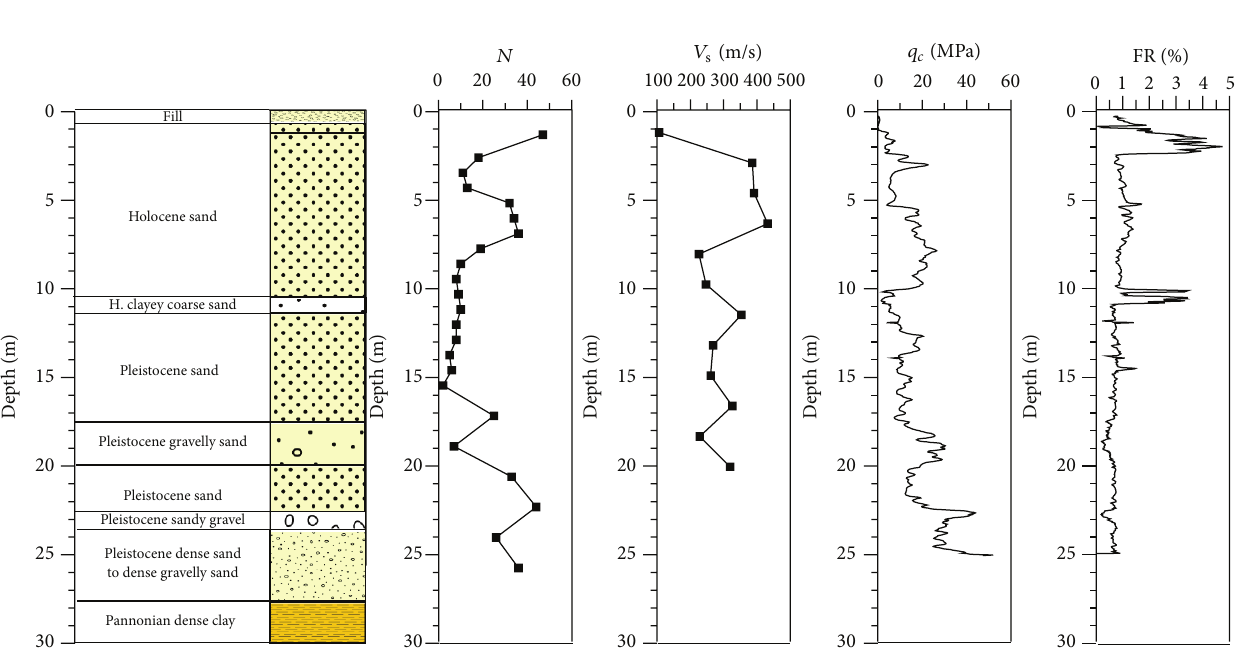
Figure 2: Soil profile, SPT blow counts ( 𝑁 ), shear wave velocities ( 𝑉 at one of the studied points, signed by